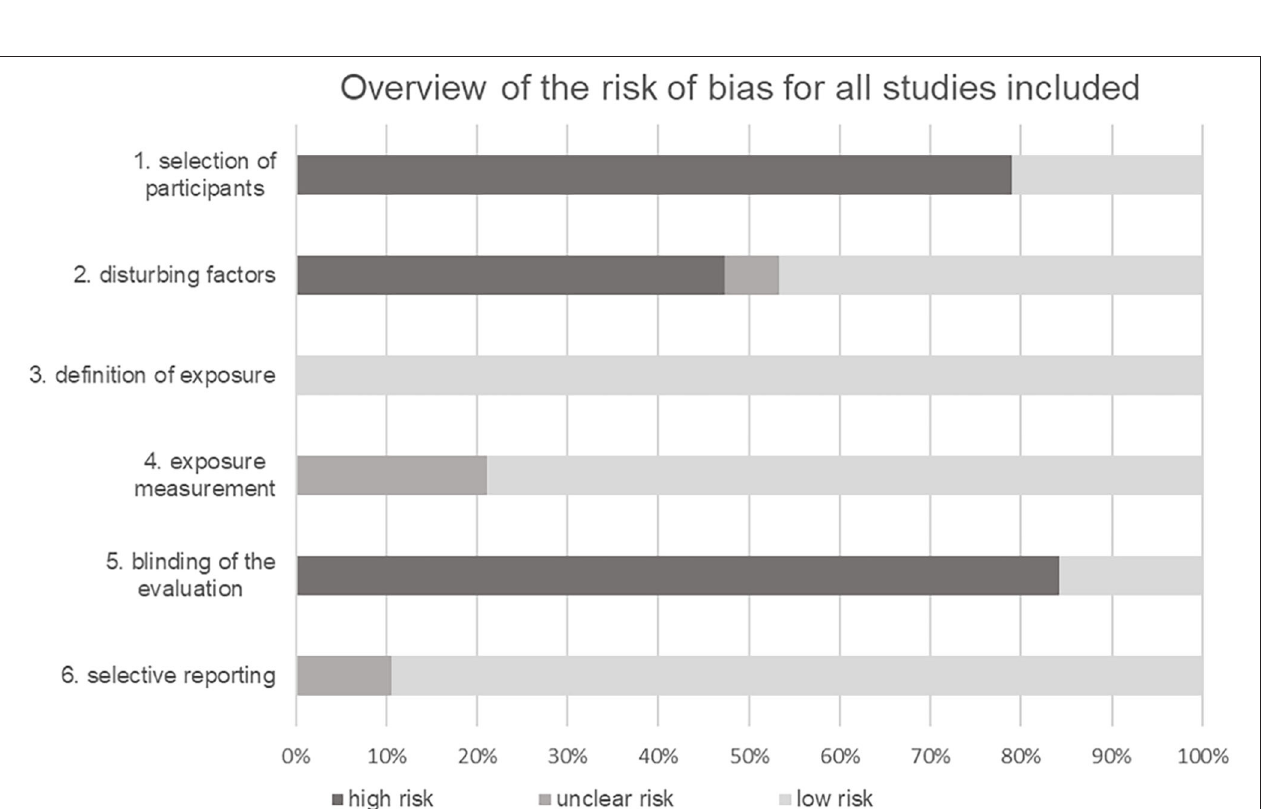
Frontiers in Physiology |